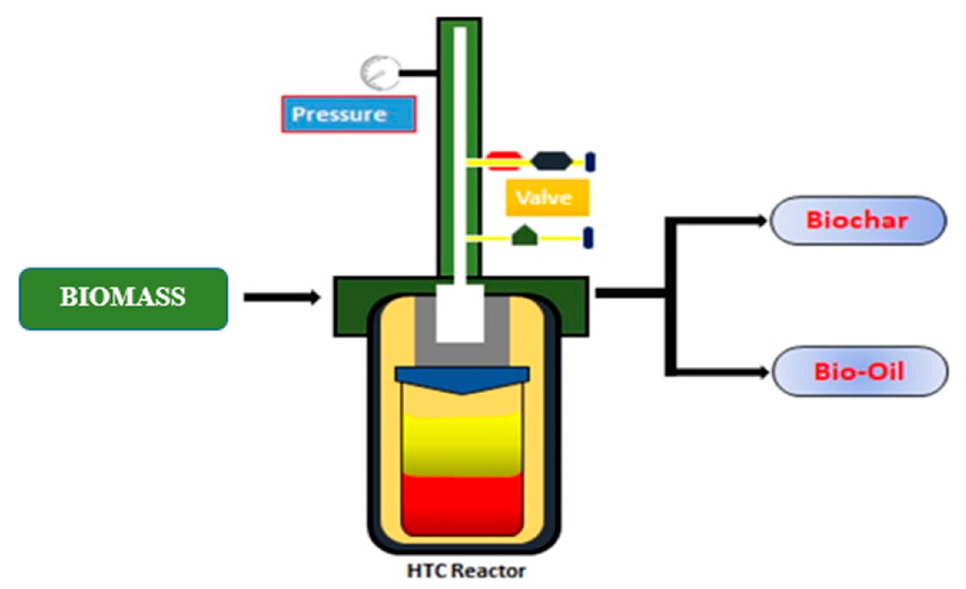
Figure 3. An example of a hydrothermal carbonization reactor used to transform biomass into biochar [43].